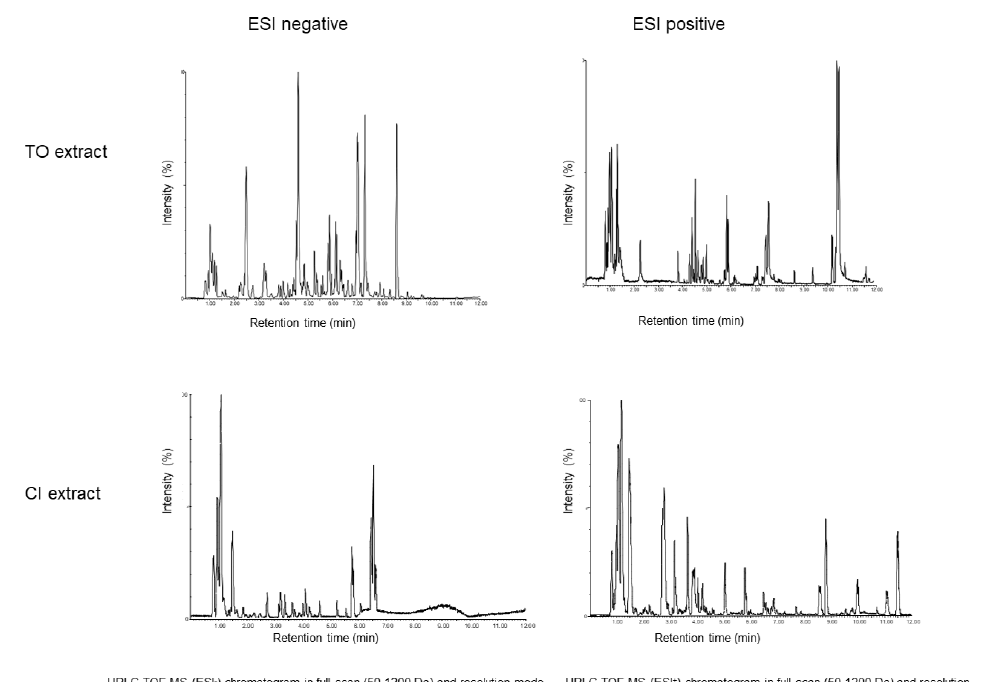
Figure 1. Metabolic analysis of T. officinale (TO) and C. intybus (CI) leaf extract using UPLC-TOF-MS. Measurements were done in high resolution mode with negative electrospray ionization (ESI-) and positive electrospray ionization